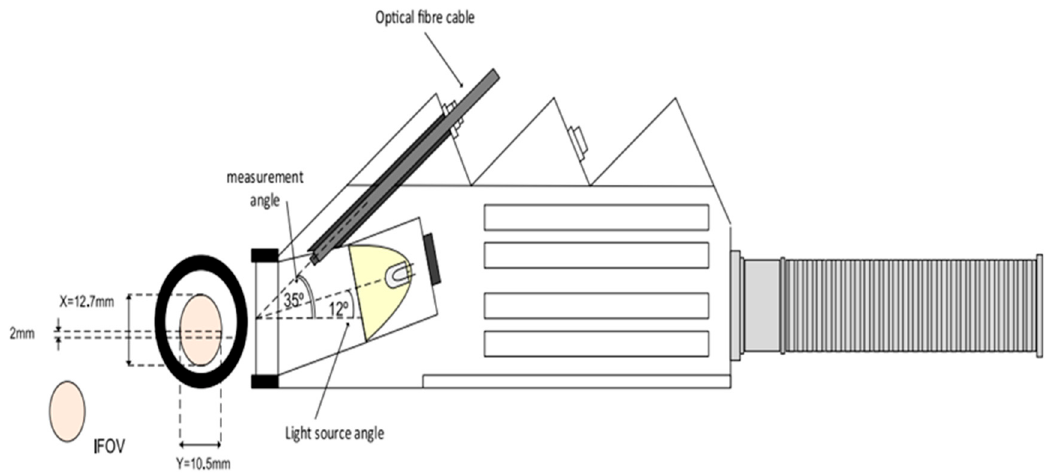
Figure 2. Illustration of the ASD high-intensity contact probe according to ASD Inc [54]. X and Y are the height and width, respectively, of the Field of View (FoV).